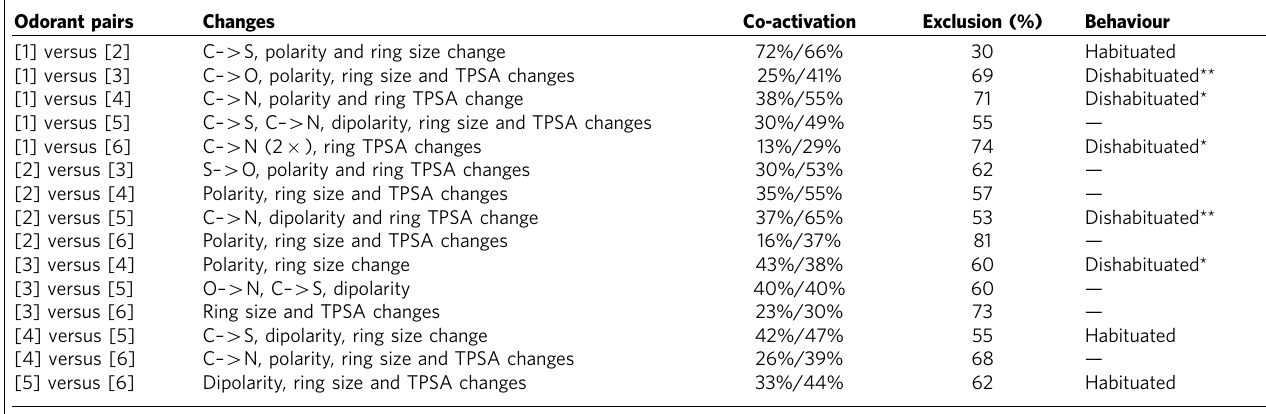
Table 1 | OSNs discrimination and behaviour response to Panel 1